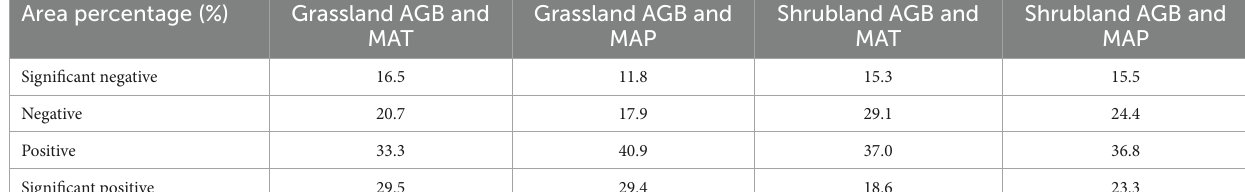
TABLE 4 Statistics of area percentage with different Influence of climate factors on AGB for grassland and shrubland: different relationships in different areas. Area percentage (%)